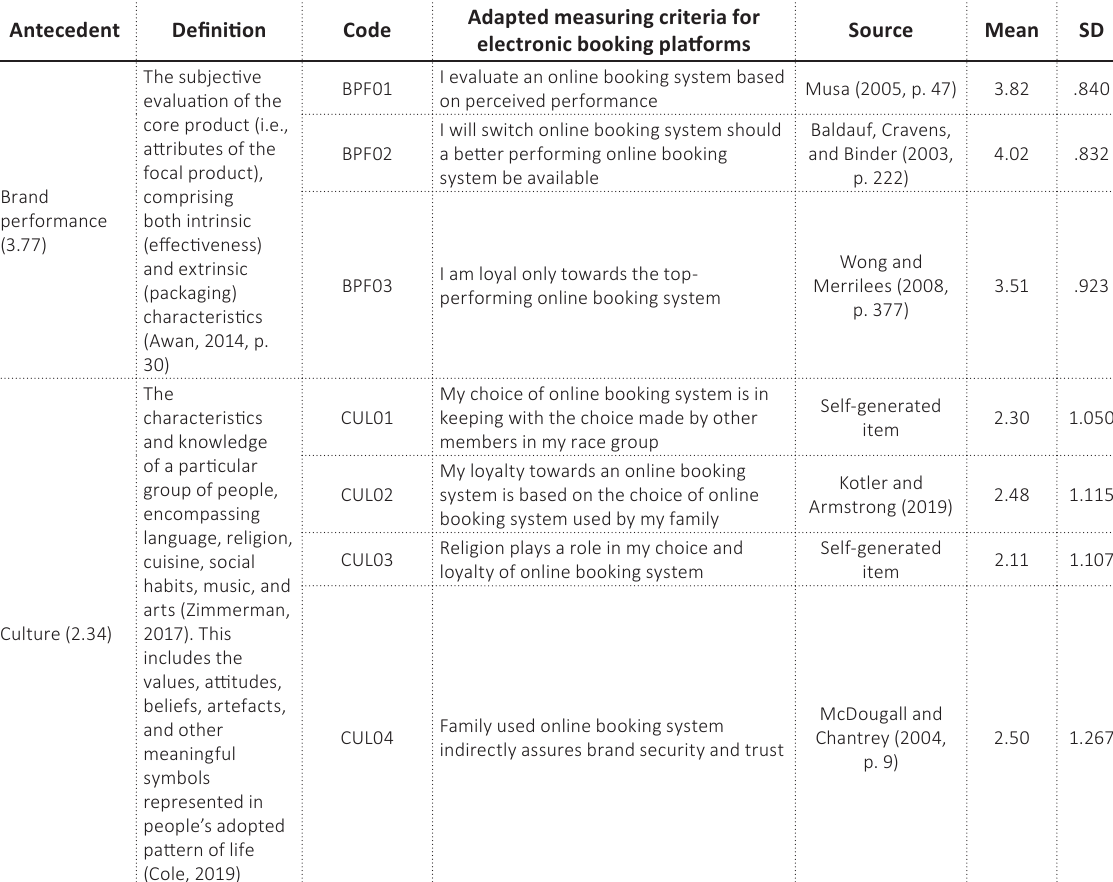
Table 1 (cont.). Descriptive statistics and the origins of the questionnaire items